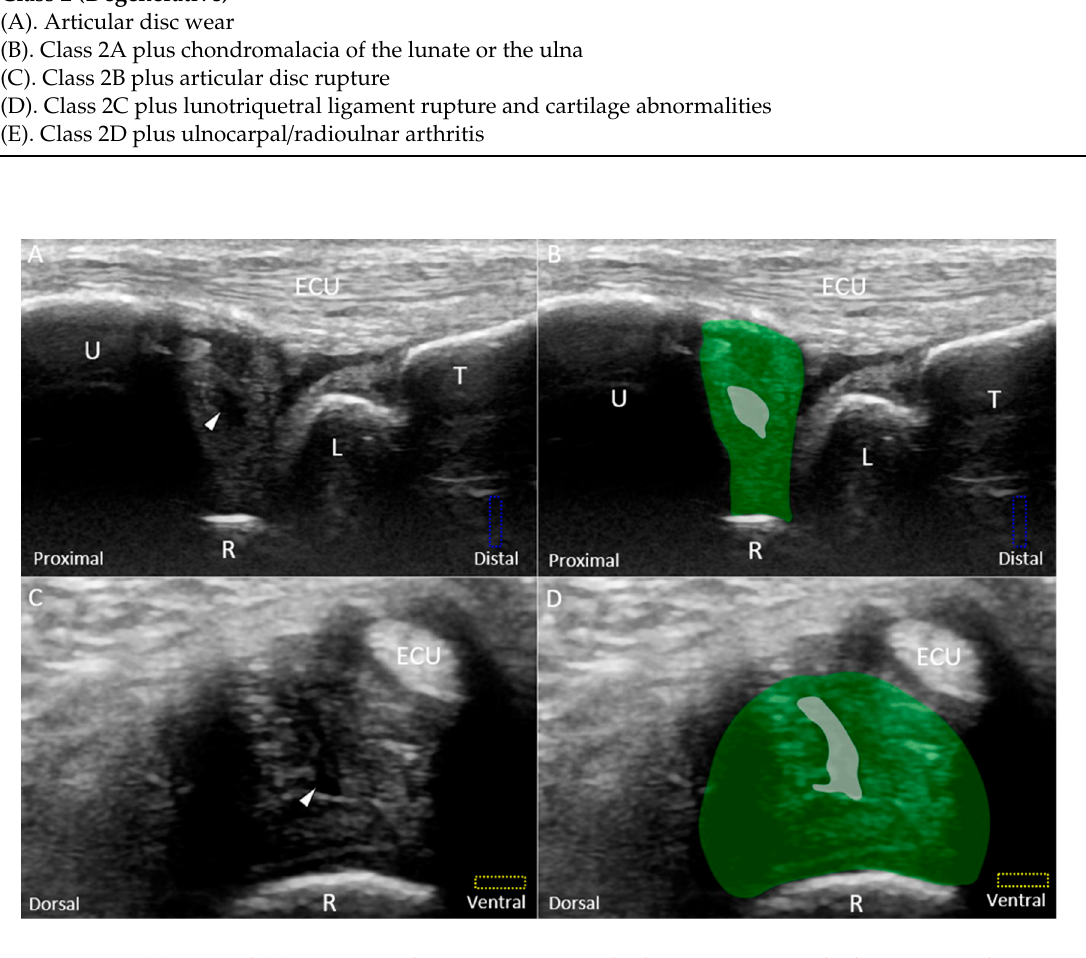
Figure 8. ( A ) US and ( B ) superposed US images using the long-axis approach show a central tear (white arrowhead and grey shade) of the articular disc (green shade) , compatible with Class 1A triangular fibrocartilage complex injury. ( C ) US and ( D ) superposed US images using the short-axis approach in the same patient. The different color dashed rectangles are in accordance with the transducer positions in Figure 3. US: ultrasound; U: ulna; R: radius; L: lunate; T: triquetrum; ECU, extensor carpi ulnaris.